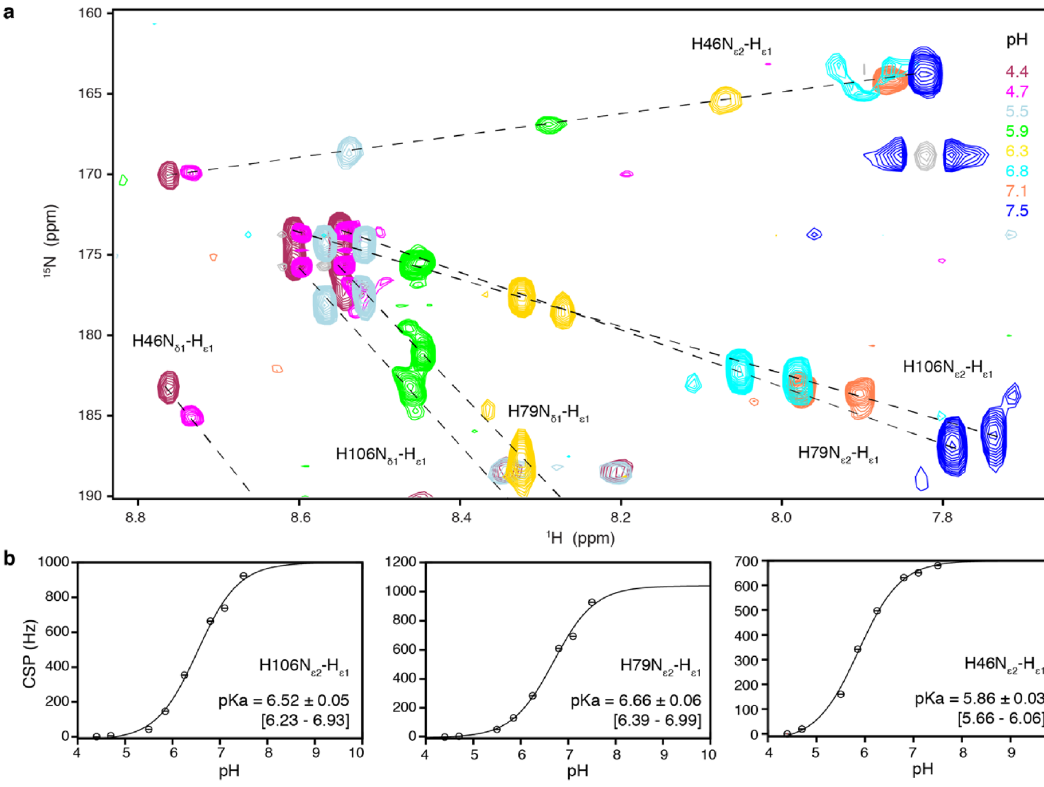
Figure 5. Determination of H2B His pKa values from side chain chemical shifts. ( a ) Overlay of HSQC spectra at indicated pH values shown, peak shift trajectories are marked with dashed lines. ( b ) CSP-derived titration curves with best-fit values of pKa and standard deviation, together with 95% confidence interval in